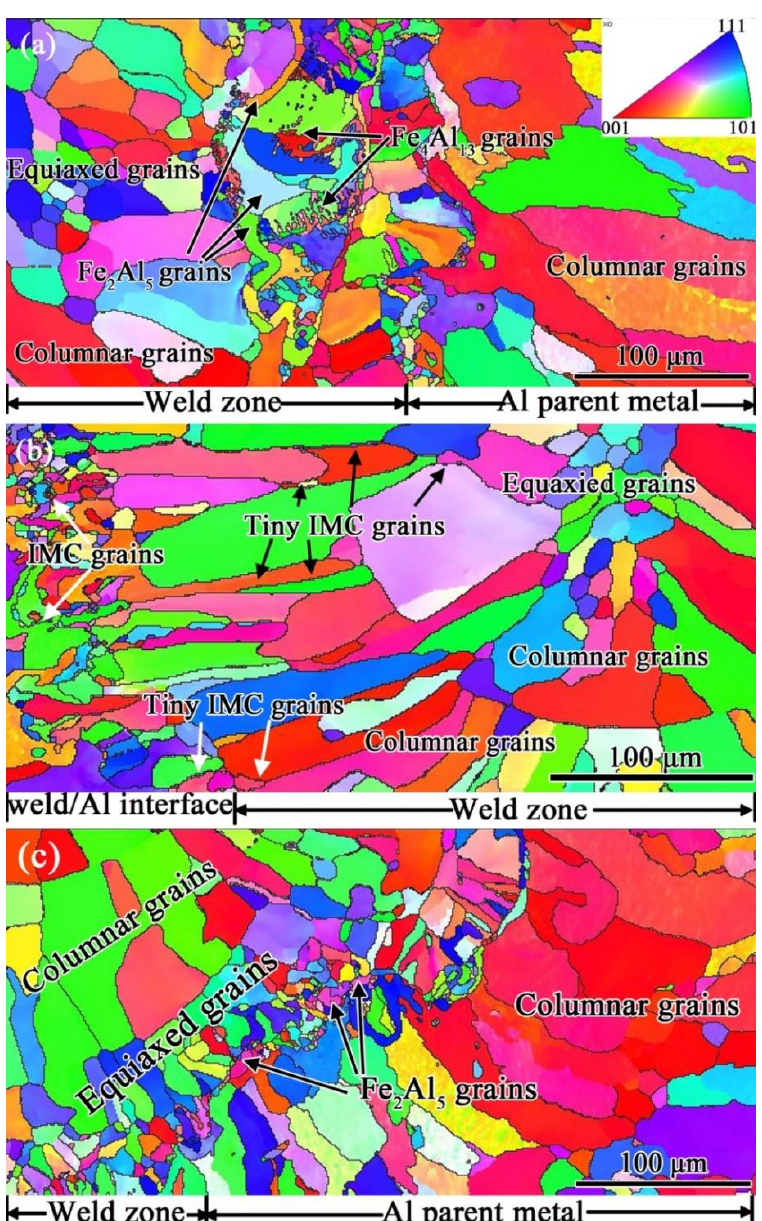
Figure 9. OIM of different zones of the steel/Al joints produced by dual-beam laser welding with side-by-side configuration: ( a ) Zone “a” marked in Figure 8e; ( b ) Zone “b” marked in Figure 8e; ( c ) Zone “c” marked in Figure 8e.